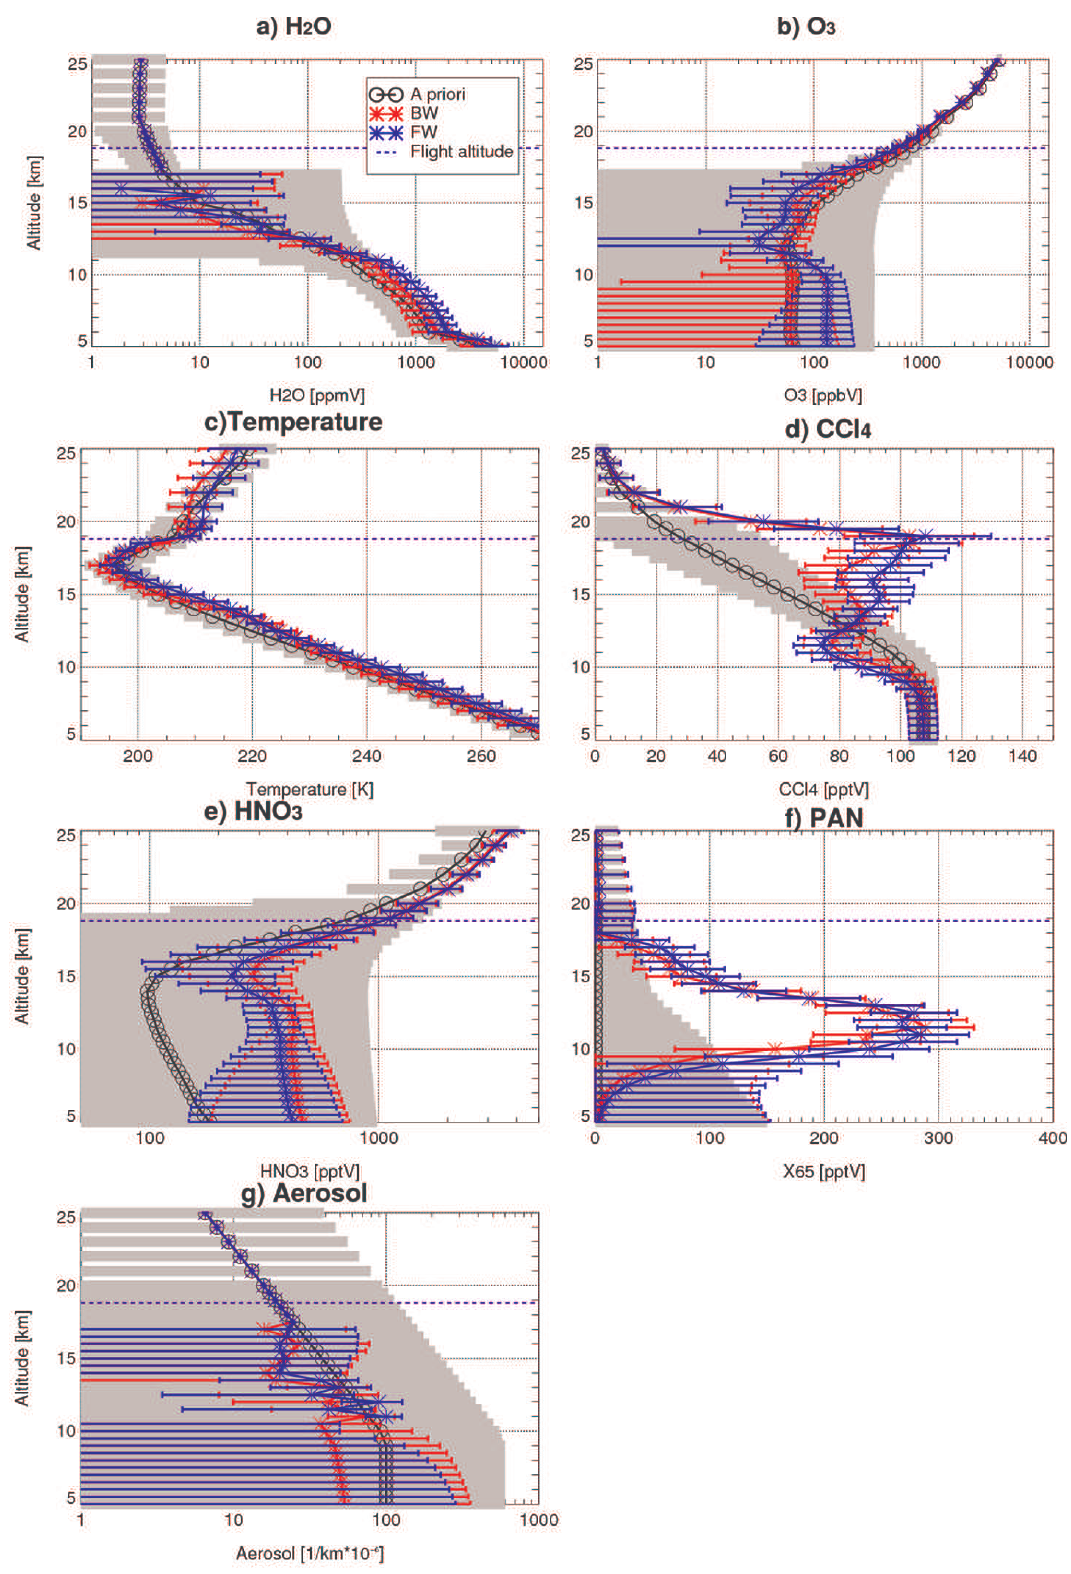
Fig. 4. Profiles for forward (FW) and backward (BW) spectra with combined plus smoothing error of H 2 O, O 3 , temperature, CCL 4 , HNO 3 , PAN, and aerosol extinction for profile 87, flight L5. The a priori standard deviation is shown in gray (y-axis